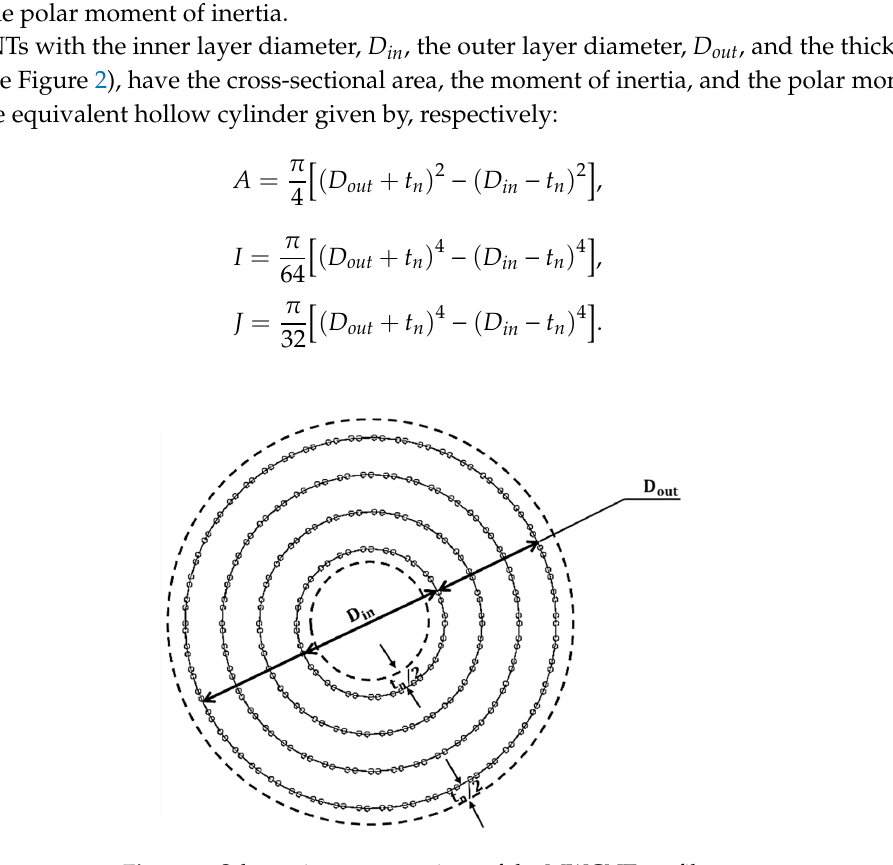
Figure 2. Schematic representations of the MWCNT profile.